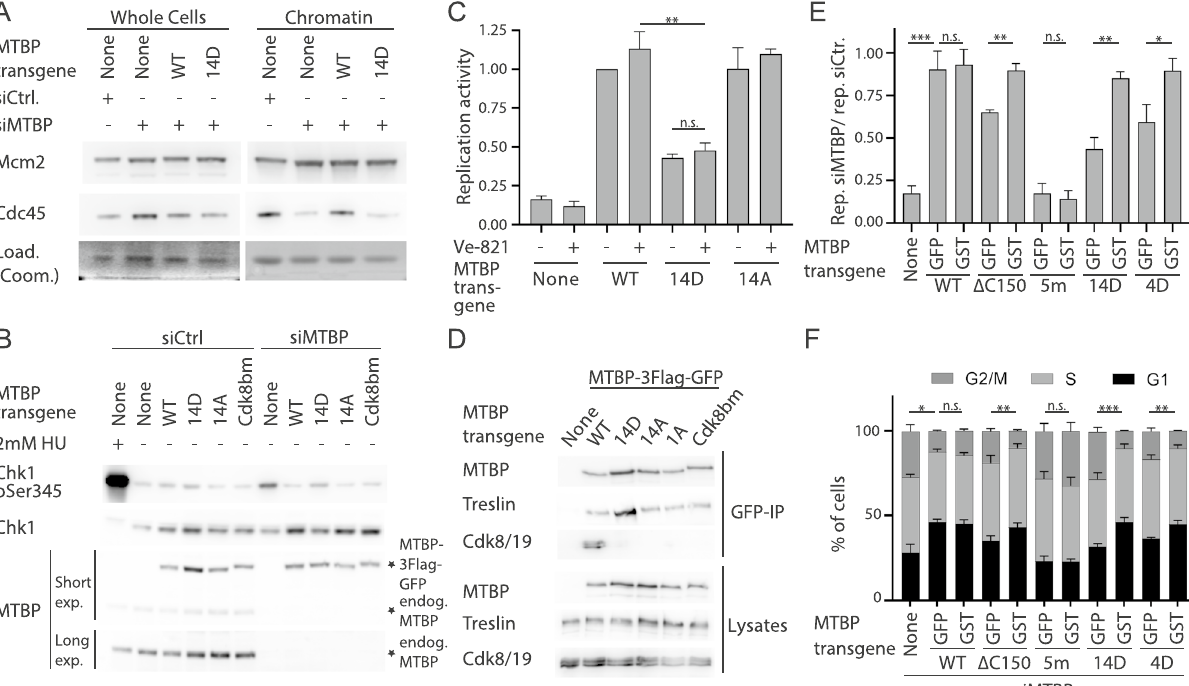
Figure 3. MTBP inhibition by phosphorylation blocks origin firing, involving suppression of the S7M-C homo-dimerization domain. ( A ) Whole cell lysates and chromatin fractions isolated from Hela Flip-In T-Rex cells expressing siMTBP resistant C-terminally 3xFlag-TEV2-GFP-tagged MTBP-wild type (WT), MTBP-14D or no transgene after siMTBP or siCtr treatment were immunoblotted using antibodies against MTBP (12H7), Mcm2 and Cdc45. Coomassie staining controlled loading (Load.). ( B ) Whole cell lysates of the indicated siCtr or siMTBP-treated Hela-FlpIn cell lines were immunoblotted using anti-MTBP (12H7), anti-Chk1, anti-pS345- Chk1. Treatment with hydroxurea (HU) was used to control for ATR signalling. ( C ) Replication activity as measured by BrdU-PI flow cytometry of the indicated cell lines upon siMTBP treatment as described in Fig. 2D. n = 3, error bars: SEM, significance tests as in 2D/E. ( D ) C-terminally 3xFlag-TEV2-GFP-tagged MTBP-wild type (WT), MTBP-14D, MTBP-14A, MTBP-1A or MTBP-Cdk8bm were transiently transfected into 293T cells before analysis by anti-GFP immunoprecipitation (IP) and immunoblotting using antibodies against MTBP (12H7), Treslin/TICRR (117) and Cdk8; MTBP mutants: MTBP-1A, amino acid exchange T687A; MTBP- Cdk8bm, amino acid exchanges L620D, P622A, L623D, F632A, V633D, L634D, T635A. ( E , F ) Quantification of replication ( E ) or cell cycle distribution ( F ) in the indicated Hela Flip-In T-Rex cell lines as described in 2D/E. n = 4 (no transgene); 4 (MTBP-WT); 4 (MTBP-ΔC150); 4 (MTBP-5 m), 3 (MTBP-14D), 3 (MTBP-4D- GS4-GFP); 5 (MTBP-4D-GS4-GST); MTBP mutants: MTBP-ΔC150, C-terminal 150 amino acids